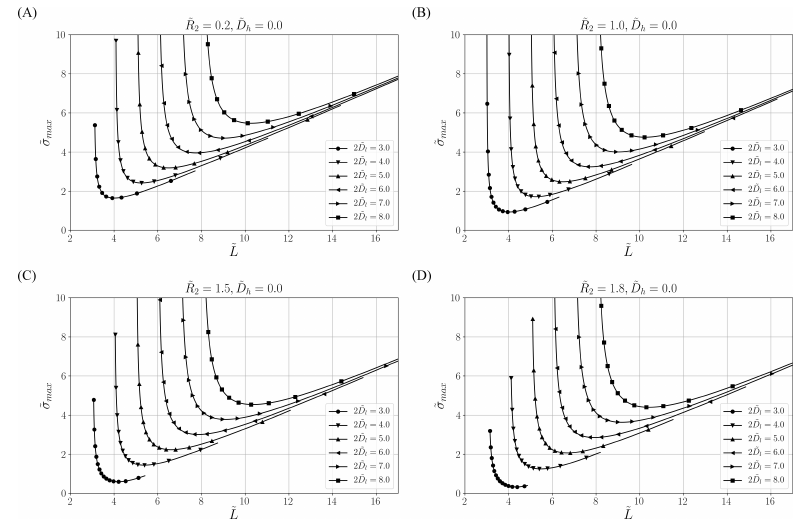
Figure 8. Plot of calculated ˜ σ max and ˜ L when ˜ D l varied.